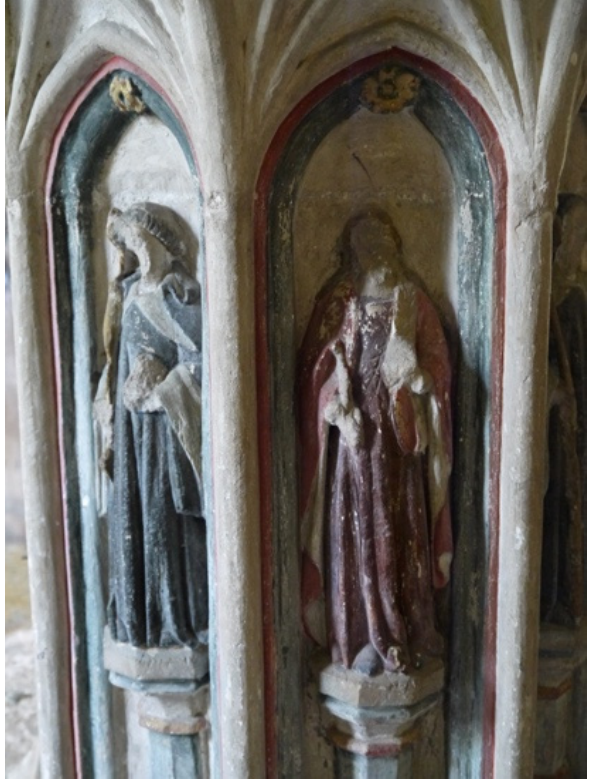
Figure 12. Coloured figures on the stem of the font at All Saints Hemblington.